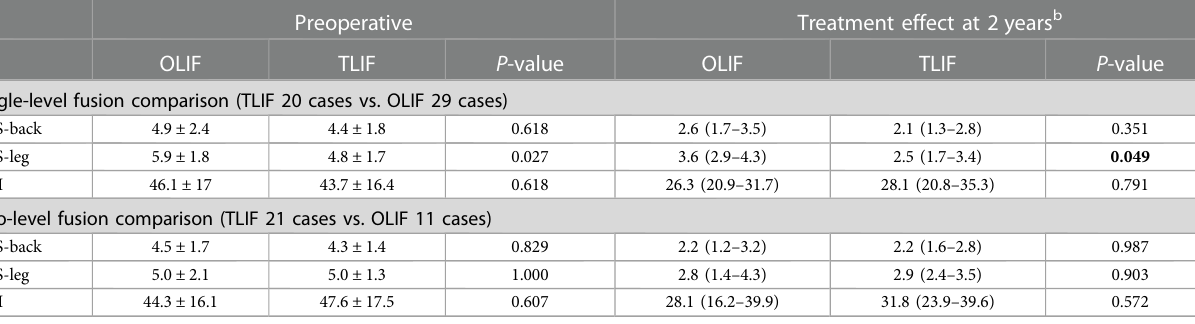
TABLE 3 Subgroup analysis of VAS and ODI between OLIF and TLIF groups a .